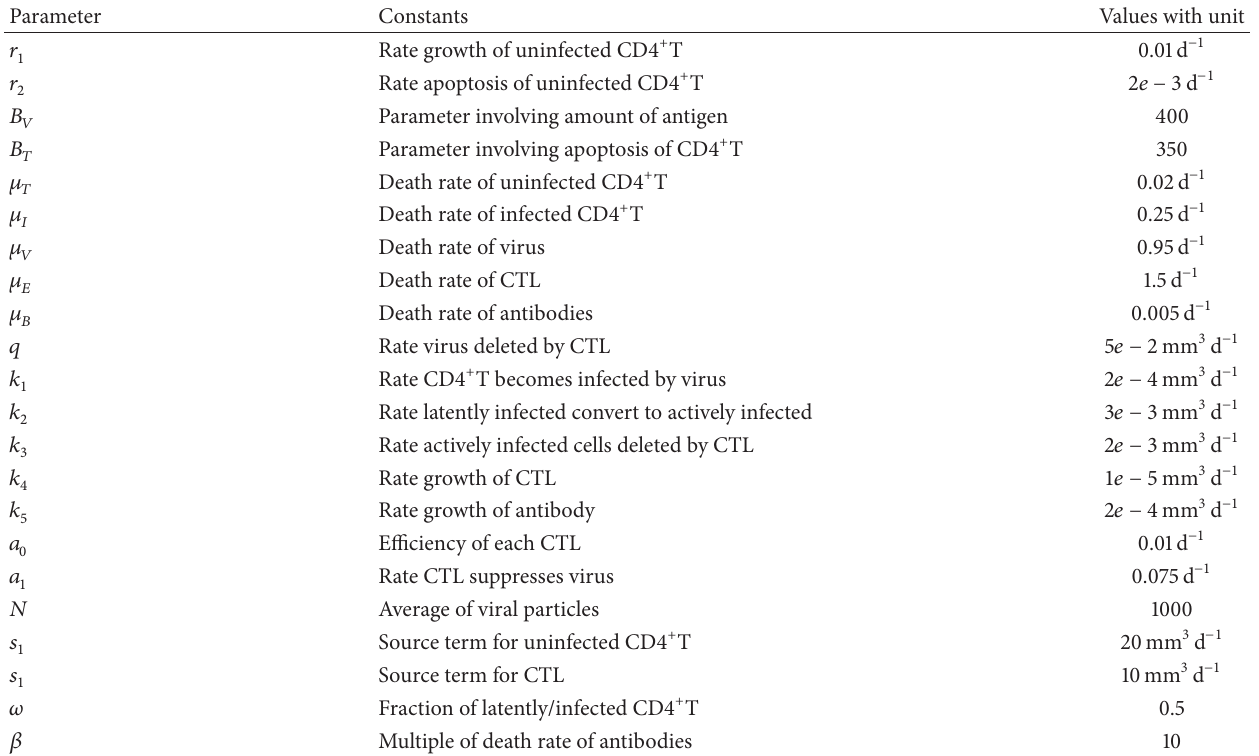
Table 1: Definitions and values for